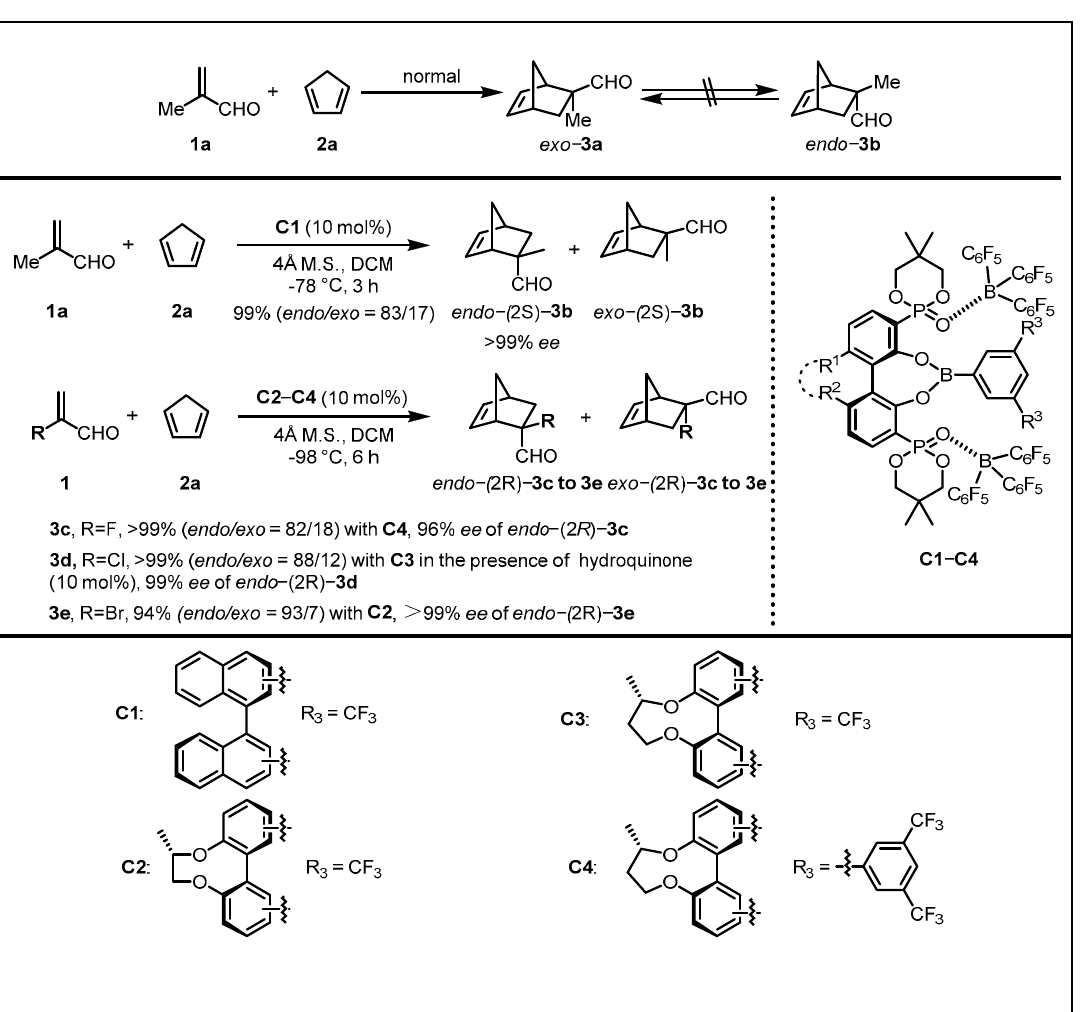
Figure 2. Anomalous endo -selective asymmetric reactions between cyclopentadiene and α -substituted acroleins.